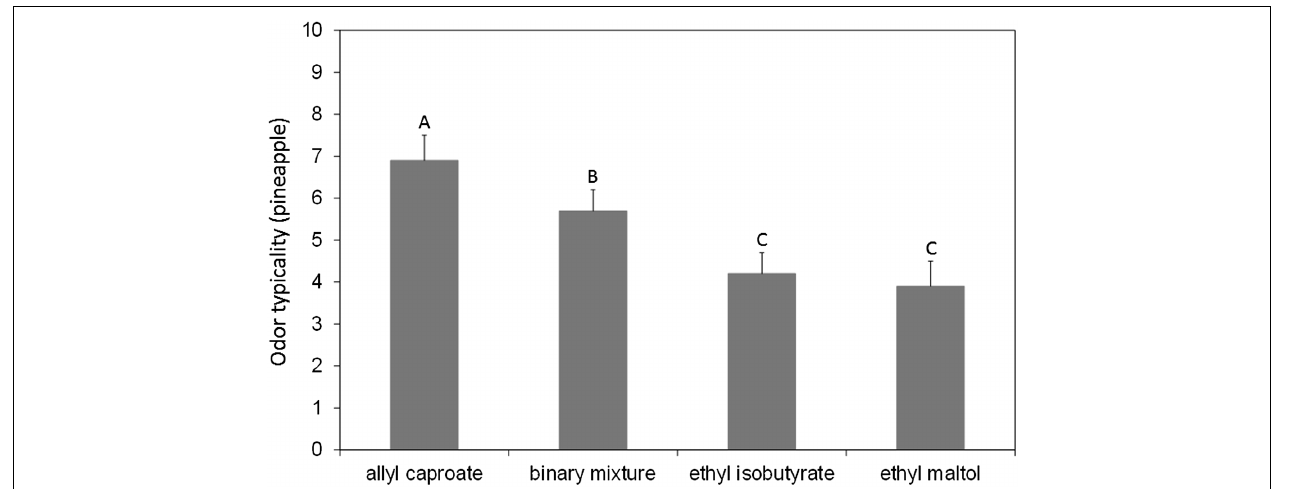
means were not different at a significance level of 5%.The results indicated that the binary mixture carried a pineapple odor that was significantly less present in the single odorants.This finding supports the idea that the odor quality of the mixture is different from those of its components (adapted from Le Berre etal.,